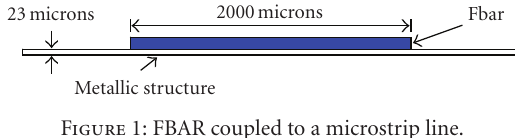
Figure 1: FBAR coupled to a microstrip line.